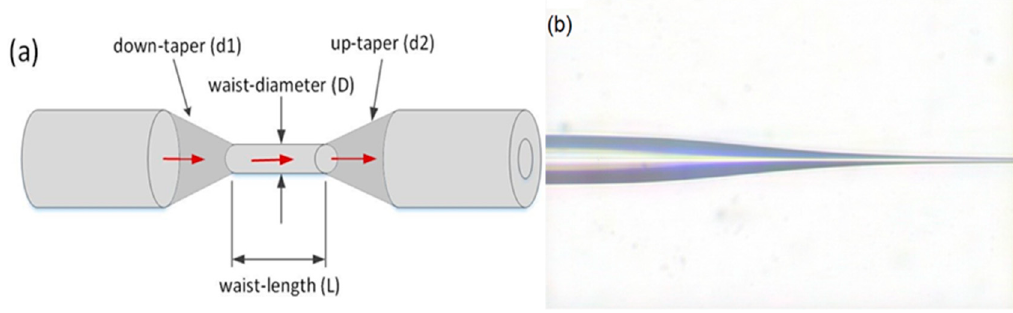
Figure 1. ( a ) Schematic of microfiber interferometer (MFI); ( b ) microscopic image of MFI.